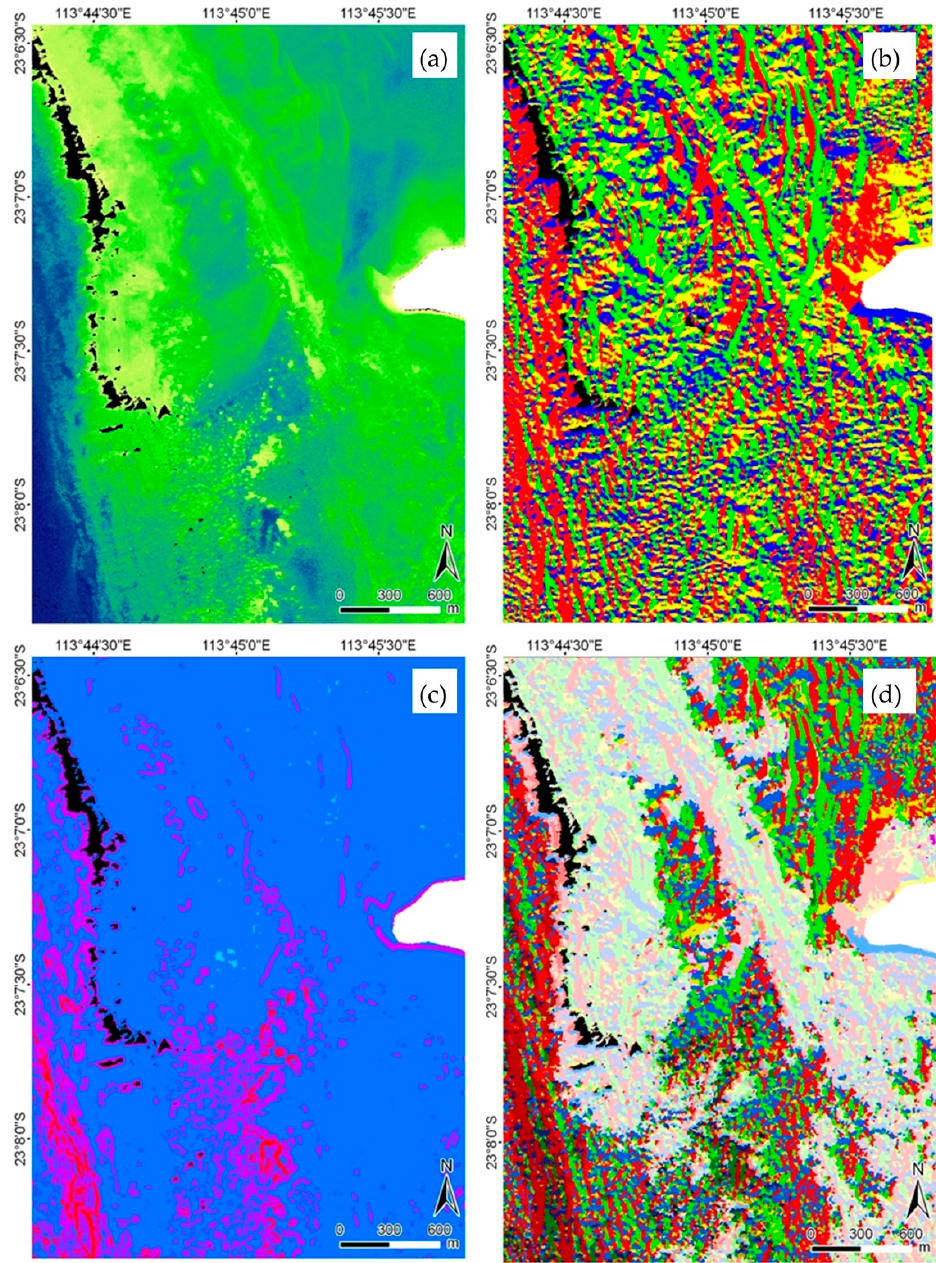
Figure 8. Topographic variables for the focus area at Point Maud, central the Ningaloo Reef. ( a ) depth, ( b ) aspect, ( c ) slope, and ( d ) topographic classification. Legends in Figure 6 apply.